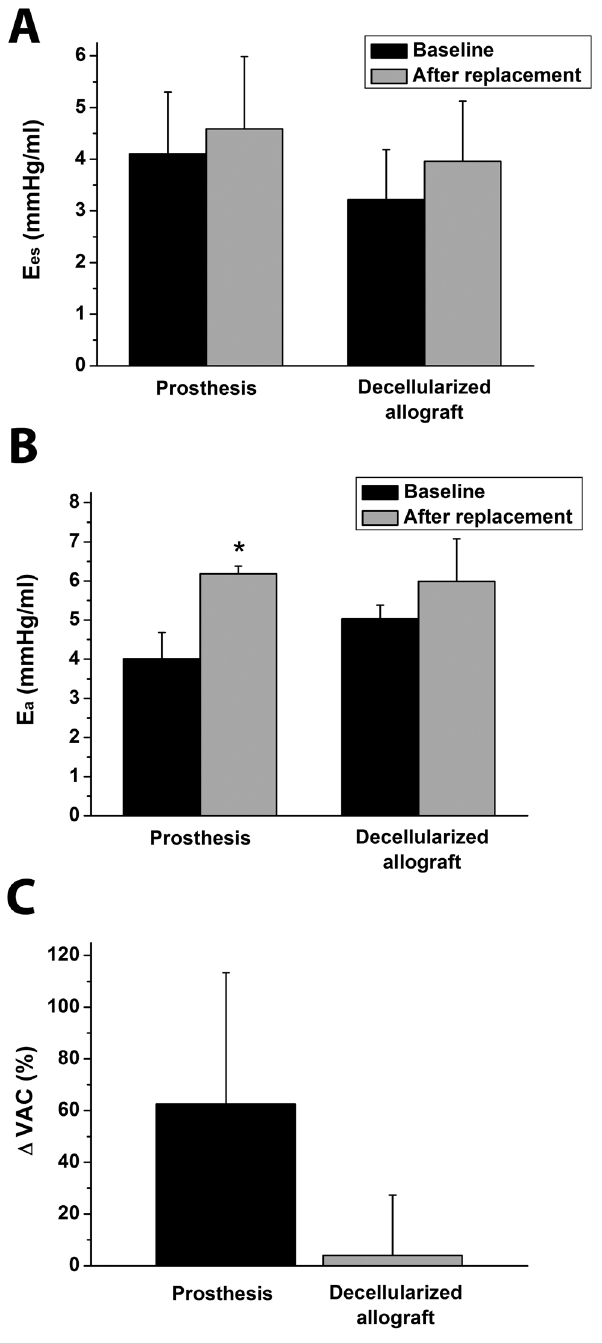
Figure 5. Contractility, afterload and ventriculoarterial cou- pling. End-systolic elastance (Ees, A), arterial elastance (Ea, B) at baseline and after total aortic arch replacement; and relative changes of ventriculoarterial coupling (VAC, C) in the prosthesis and decellularized allograft groups. All values are given as means 6 SEM, *:P , 0.05 vs. Baseline